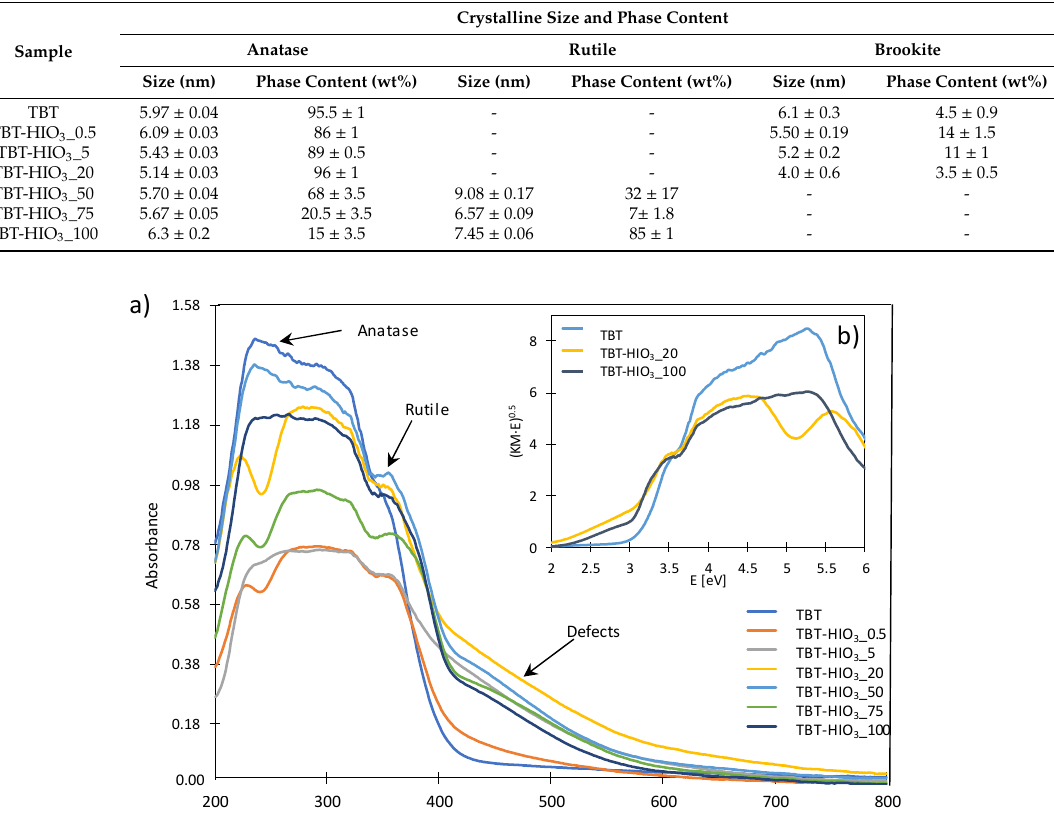
Figure 9 . The EPR spectra recorded in the room temperature for selected defective TiO 2 -HIO 3 photocatalysts, compared with the pure TiO 2 –TBT sample (blue line).